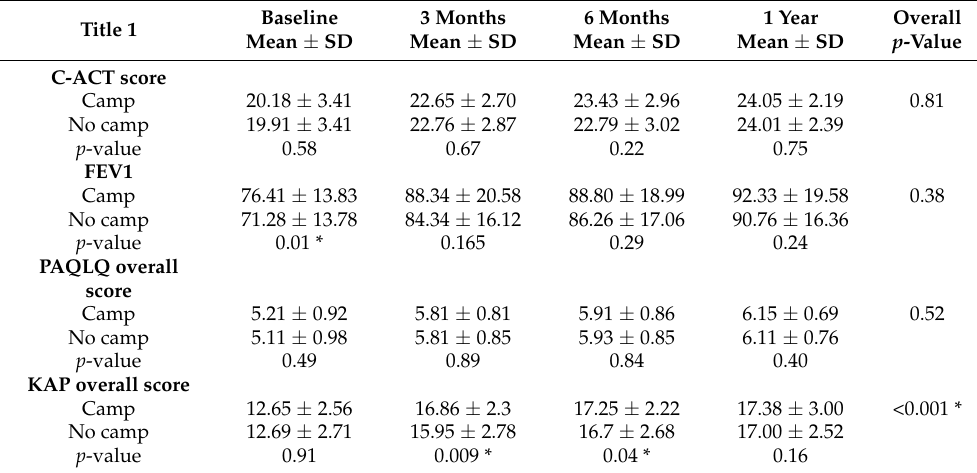
Table 2. Outcomes of C-ACT score, FEV1 value, overall PAQLQ score, and overall KAP score at each